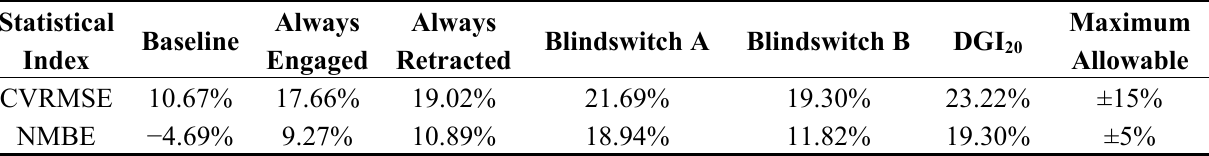
Table 6. Statistical indices for